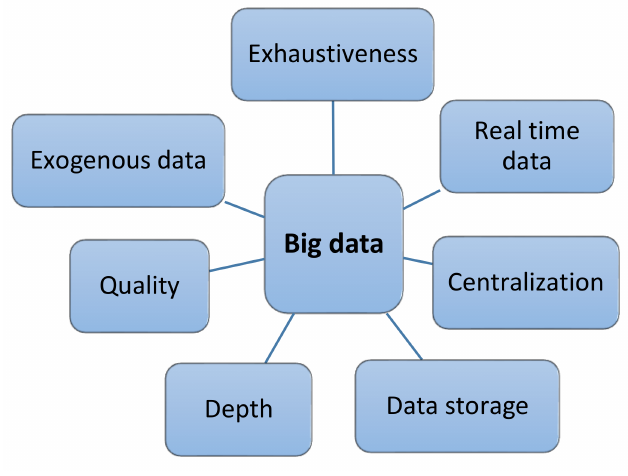
Figure 6. The big data characteristics in the railway stations